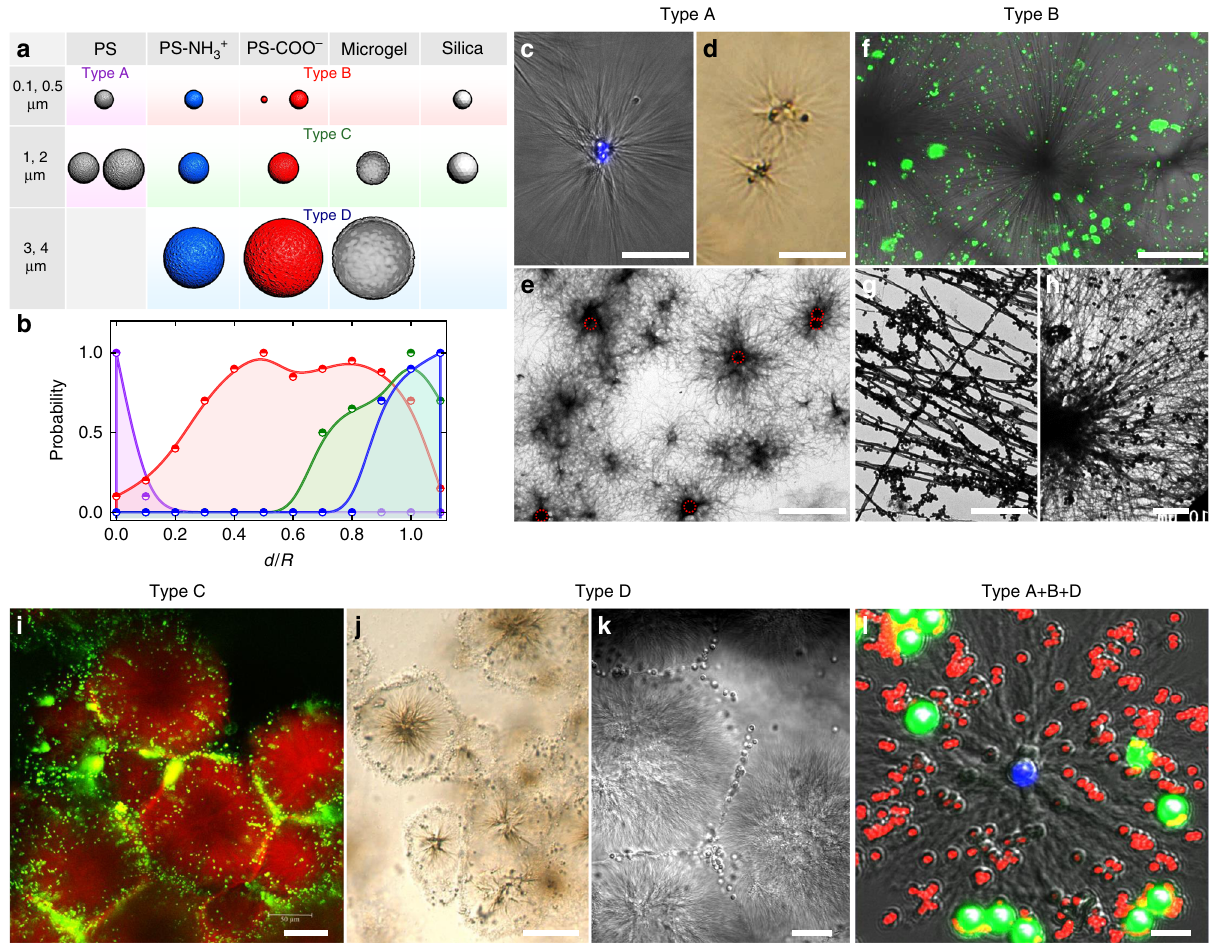
Fig. 4 Positioning capability of the asters. a Categorization of the polystyrene (PS), amine-modi fi ed PS (PS-NH 3 + ), carboxylate-modi fi ed PS (PS-COO − ), poly( N -isopropylacrylamide) hydrogel (microgel), and silica particles into four types according to particle size and surface chemistry. The spherical representations are not scaled to size. b Statistics of spatial distributions of the particles along aster radius. Purple to blue denotes type A to D. c – e Type-A particles (2 μ m PS in c and 1 μ m PS in d , e ) resides in the aster cores. f – h Type-B particles (0.1 μ m PS-NH 3 + in f , g and 0.5 μ m PS-COO − in h ) spread along the aster ribbons. i Type-C particles (1 μ m PS-COO − ) are distributed near the outer rims. j , k Type-D particles (4 μ m PS-COO − in j and 4 μ m microgel in k ) are exclusively localized along the peripheries. l Different particles are sorted into respective localizations (2 μ m blue PS in the core, 0.5 μ m red PS-COO − along the ribbons, and 4 μ m green PS-COO − by the periphery). Scale bars = 50 μ m ( c , d ), 5 μ m ( e ), 50 μ m ( f ), 2 μ m ( g ), 5 μ m ( h ), 50 μ m ( i ), 100 μ m ( j ), 20 μ m ( k ), and 5 μ m ( l